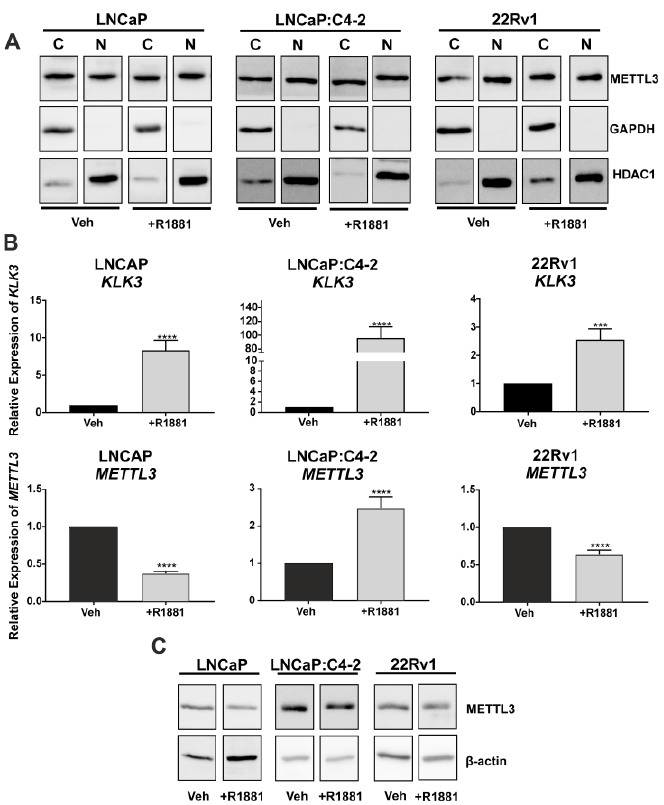
Figure 2. METTL3 expression in PCa cell lines. ( A ) METTL3 protein expression was examined in the nuclear and cytoplasmic compartments of PCa cell lines LNCaP, LNCaP:C4-2, and 22Rv1. Cytoplasmic and nuclear loading controls used were GAPDH and HDAC1, respectively. Androgen regulation of KLK3 and METTL3 mRNA ( B ) and METTL3 protein ( C ) expression was analysed. Veh = vehicle, C = cytoplasmic, N = nuclear. *** p ≤ 0.001, **** p ≤ 0.0001. Molecular weights for proteins are indicated in the full annotated Western blot images (Figures S1 – S6).